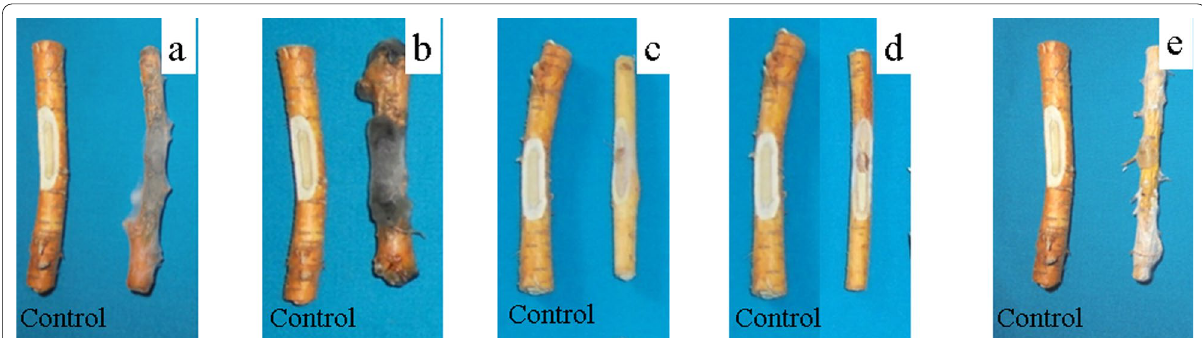
Fig. 1 In-vitro pathogenicity test. a Macrophomina phaseolina , b Lasiodiplodia theobromae , c Fusarium solani , d Rhizoctonia solani ; e Sclerotium